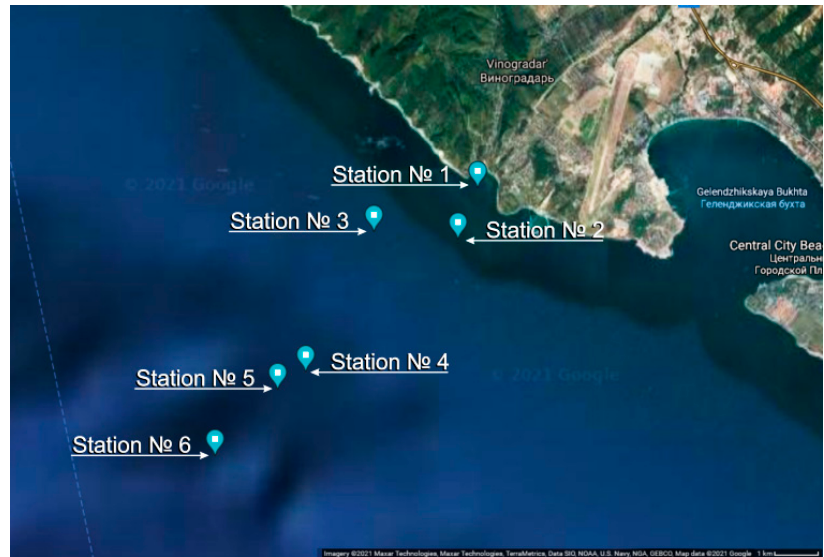
Figure 4. Studied water area and location of the stations: station no. 1 with coordinates 44°34.3623 ′ N 37°58.7232 ′ E, submersion up to 7 m (25 June 2019); station no. 2—44°33.7943 ′ N 37°58.4186 ′ E, up